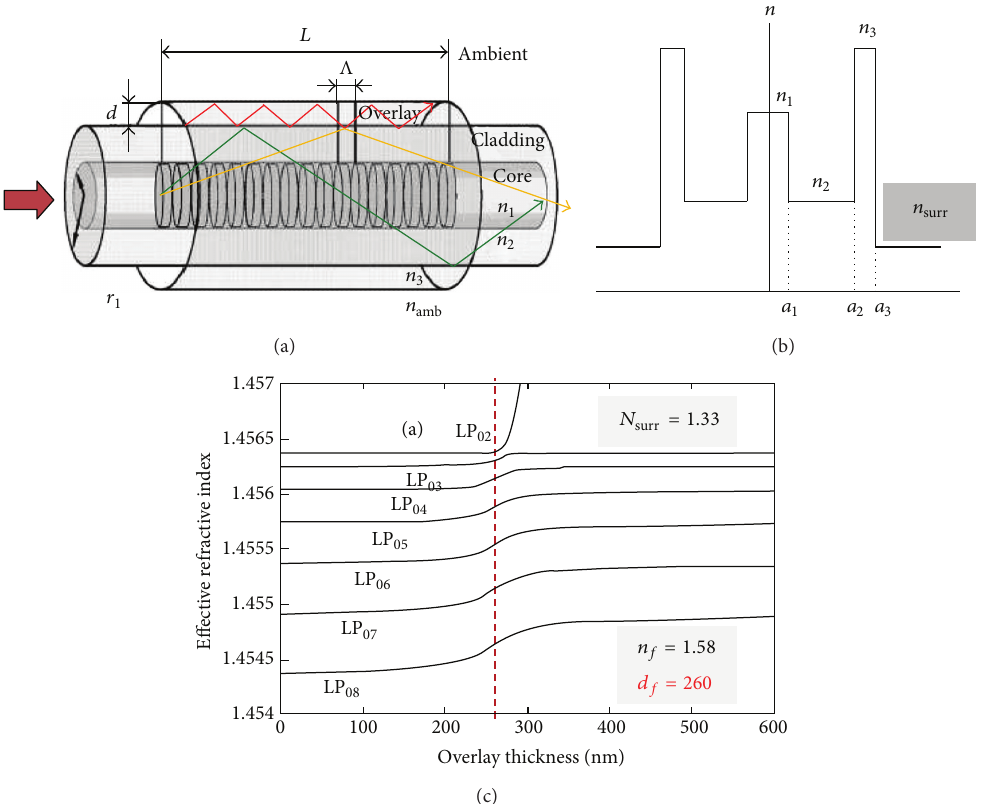
Figure 9: (a) A mode guided by the thin film (the ray trace in red), (b) refractive index profile, and (c) the transition region (adapted from [43, 44]).